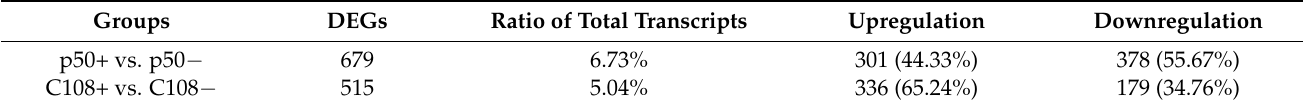
Table 4. Statistical analysis of DEGs in two strains following inoculation.